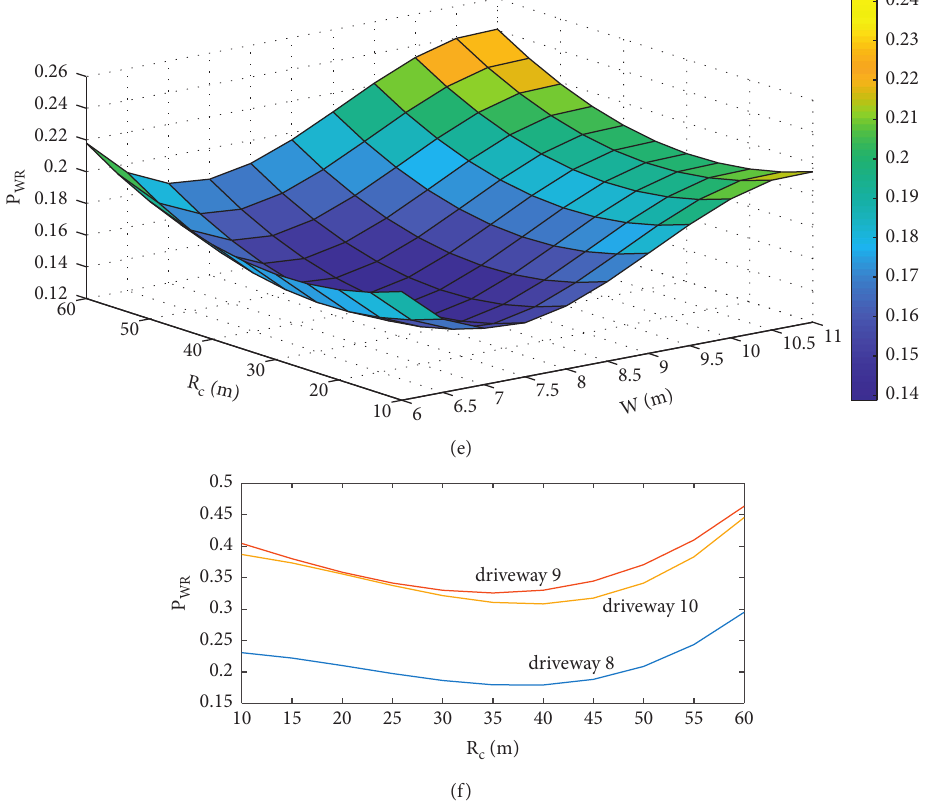
Figure 19: Curves of relationship among P 6. (e) Driveway 7. (f) Driveways 8, 9, and 10.